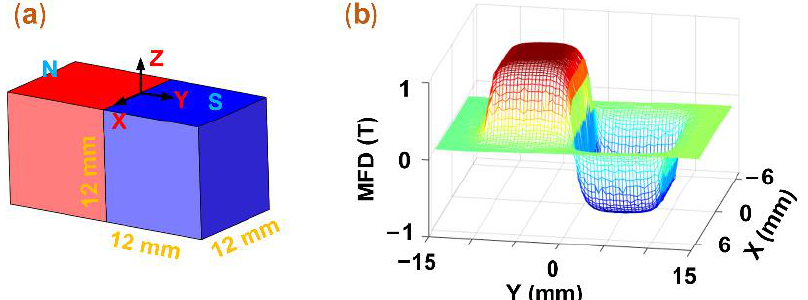
Figure 3. The simulation of the MFD. ( a ) the simulation model; ( b ) the MFD distribution in the Z direction of the model.